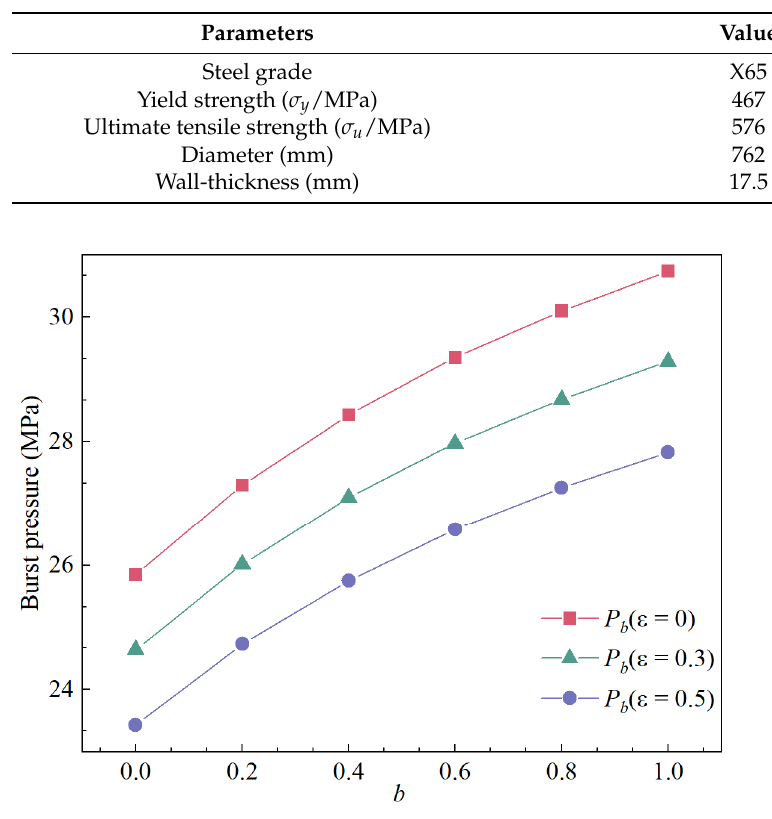
Figure 4. The influence of parameter b on burst pressure.